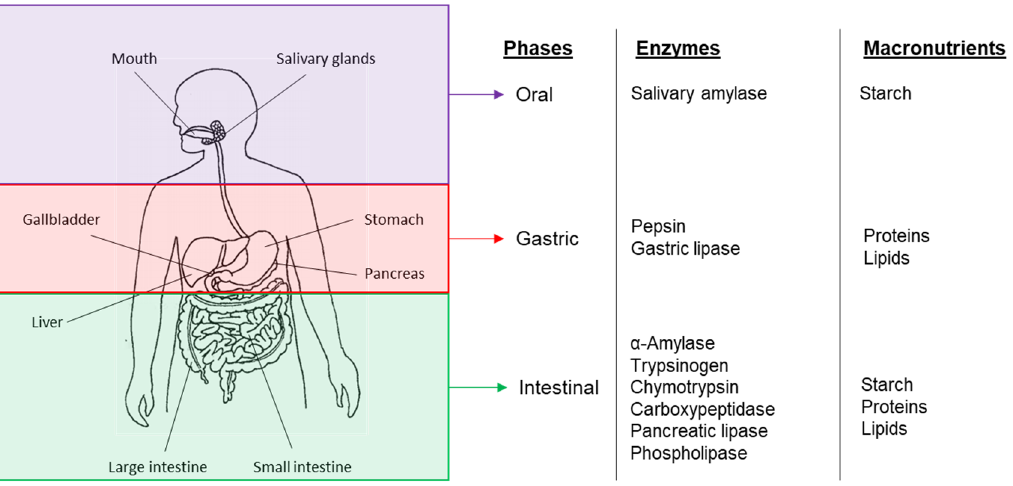
Figure 4. The human digestive system—Diagram of the GIT compartments in which macronutrients are digested and the main enzymes involved.